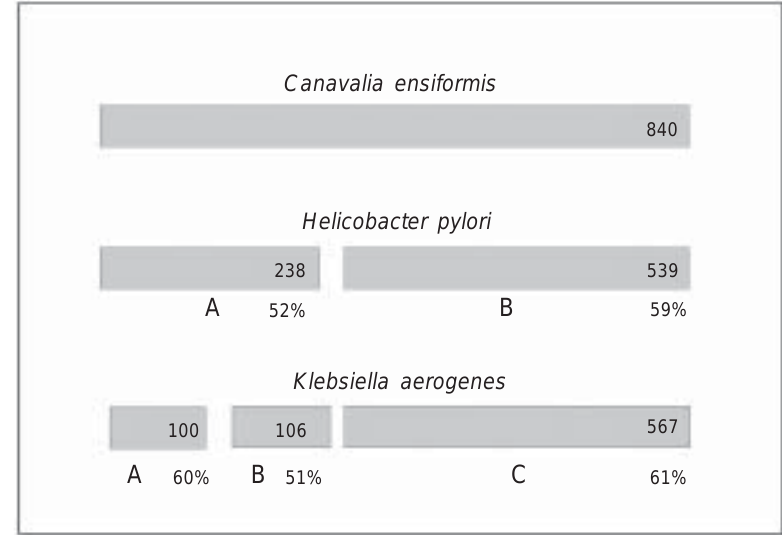
Figure 1. Schematic structure of ureases. Plant ureases such as the jack bean ( Canavalia ensiformis ) enzyme have a single subunit while bacterial ureases have two ( Helicobacter pylori ) or three ( Klebsiella aerogenes ) subunits. The number of amino acid residues of each subunit is indicated. Note that the length of each box is not drawn to scale of total amino acids. The percentage of identity to the corresponding fragment of the jack bean urease is shown under the bacterial